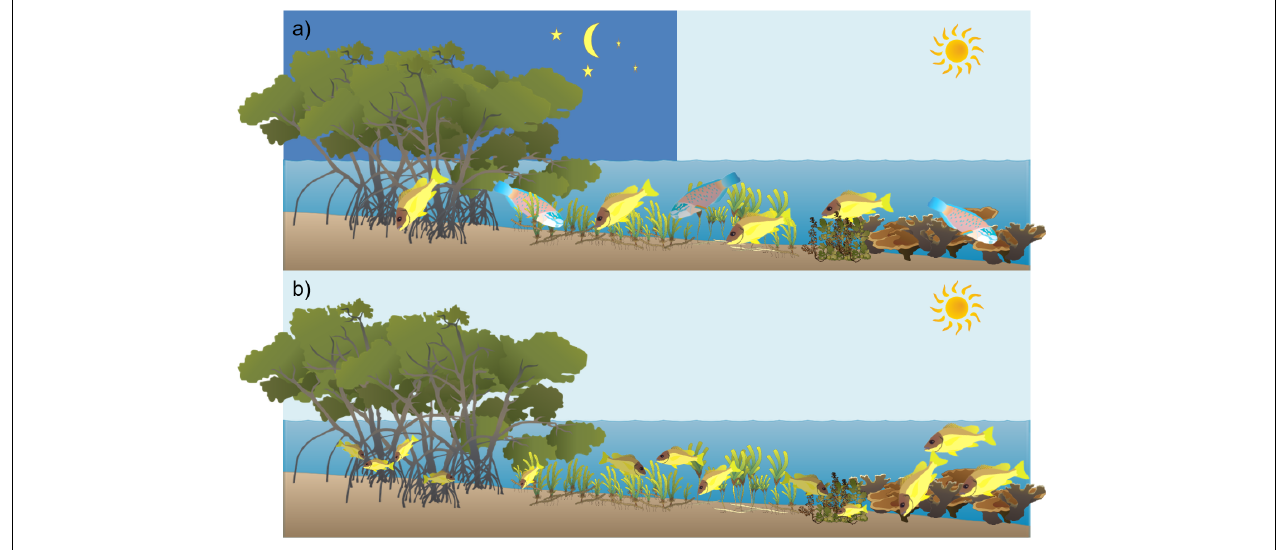
FIGURE 1 | Schematic illustration adopted from Berkström (2012) showing (a) dial and tidal foraging migrations between coral reef, macroalgae, seagrass, and mangrove habitats and (b) ontogenetic migration of juvenile coral reef fish between the above-mentioned habitats within tropical seascapes. Image symbol courtesy of the Integration and Application Network, University of Maryland and Stina